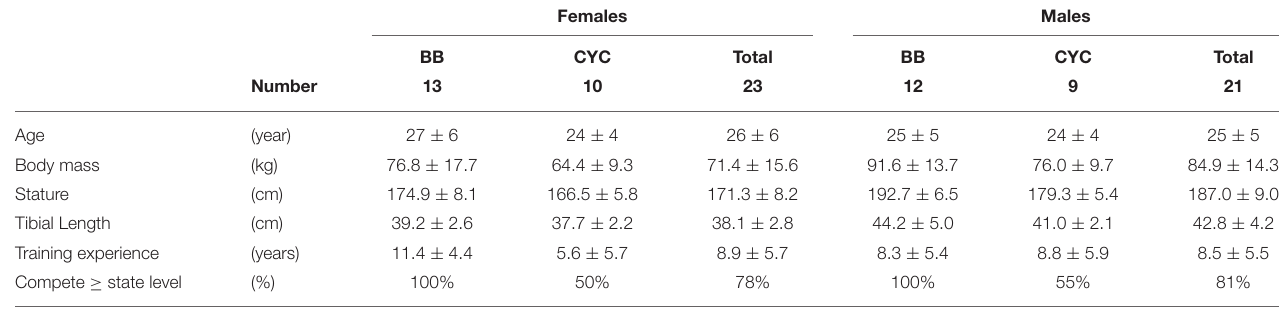
TABLE 1 | Participant characteristics (mean ± SD).